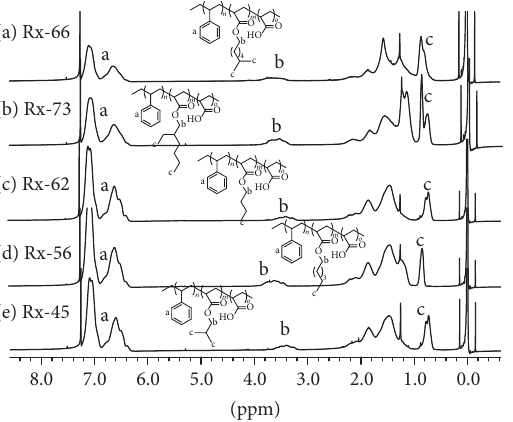
Figure 1: 1 H-NMR spectra of microspheres prepared in this study containing different comonomers. (a) Poly(Sty- co -IOA- co -AA). (b) Poly(Sty- co -EHA- co -AA). (c) Poly(Sty- co -BA- co -AA). (d) Poly(Sty- co -HA- co -AA). (e) Poly(Sty- co -IBA- co -AA).